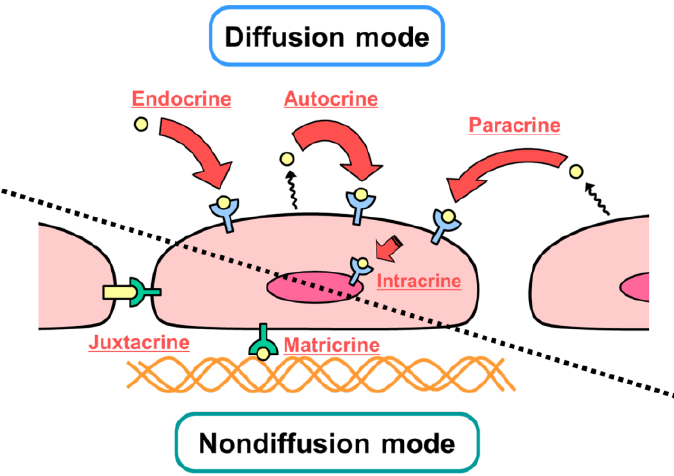
Figure 1. Modes of action of growth factors. Growth factors interact with their receptors in a diffusible manner (e.g., by endocrine, paracrine, autocrine and intracrine pathways) or in a nondiffusible manner (e.g., by juxtacrine and matricrine pathways). Some growth factors are known to act in both